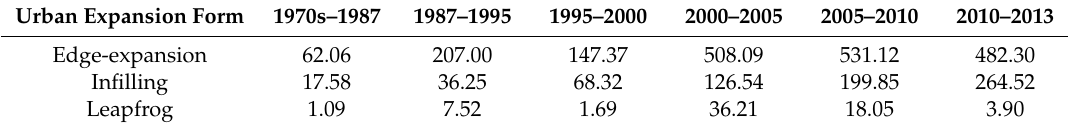
Table 1. Urban expansion rates of three forms (unit: km 2 per year).